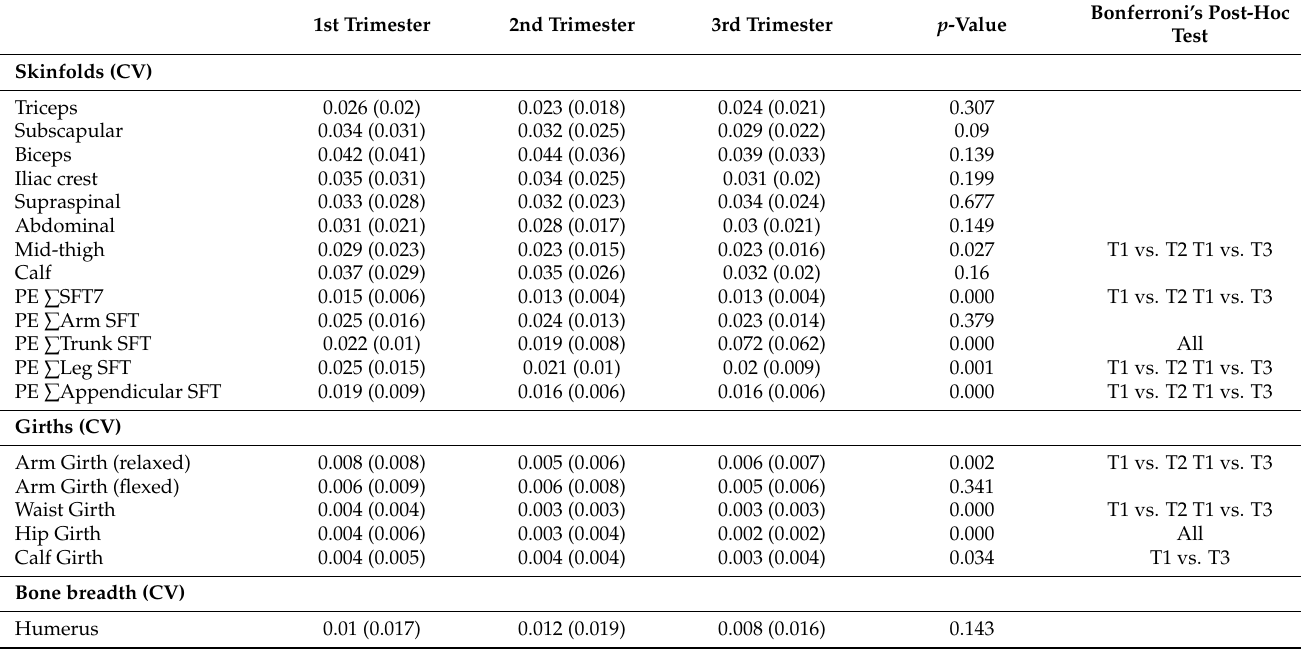
Table 4. Reliability and agreement of skinfold, circumference and diameter measurements for the three trimesters during